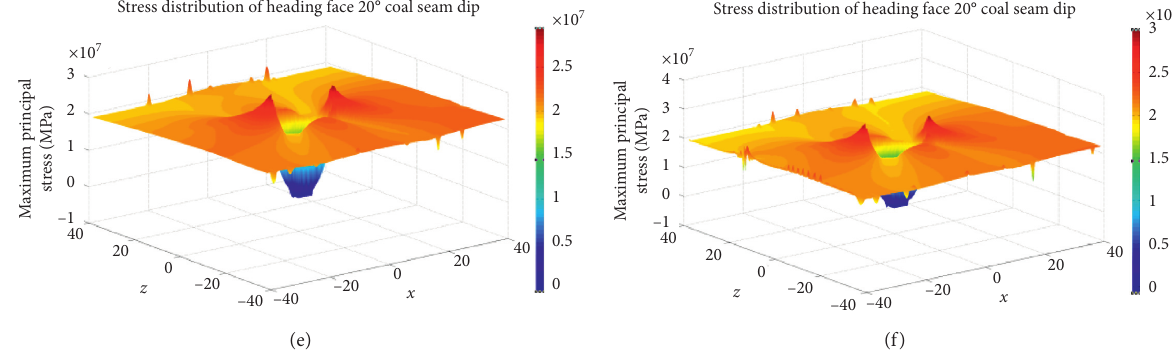
Figure 3: Three-dimensional diagram of the section stress of the roadway heading head under each coal seam